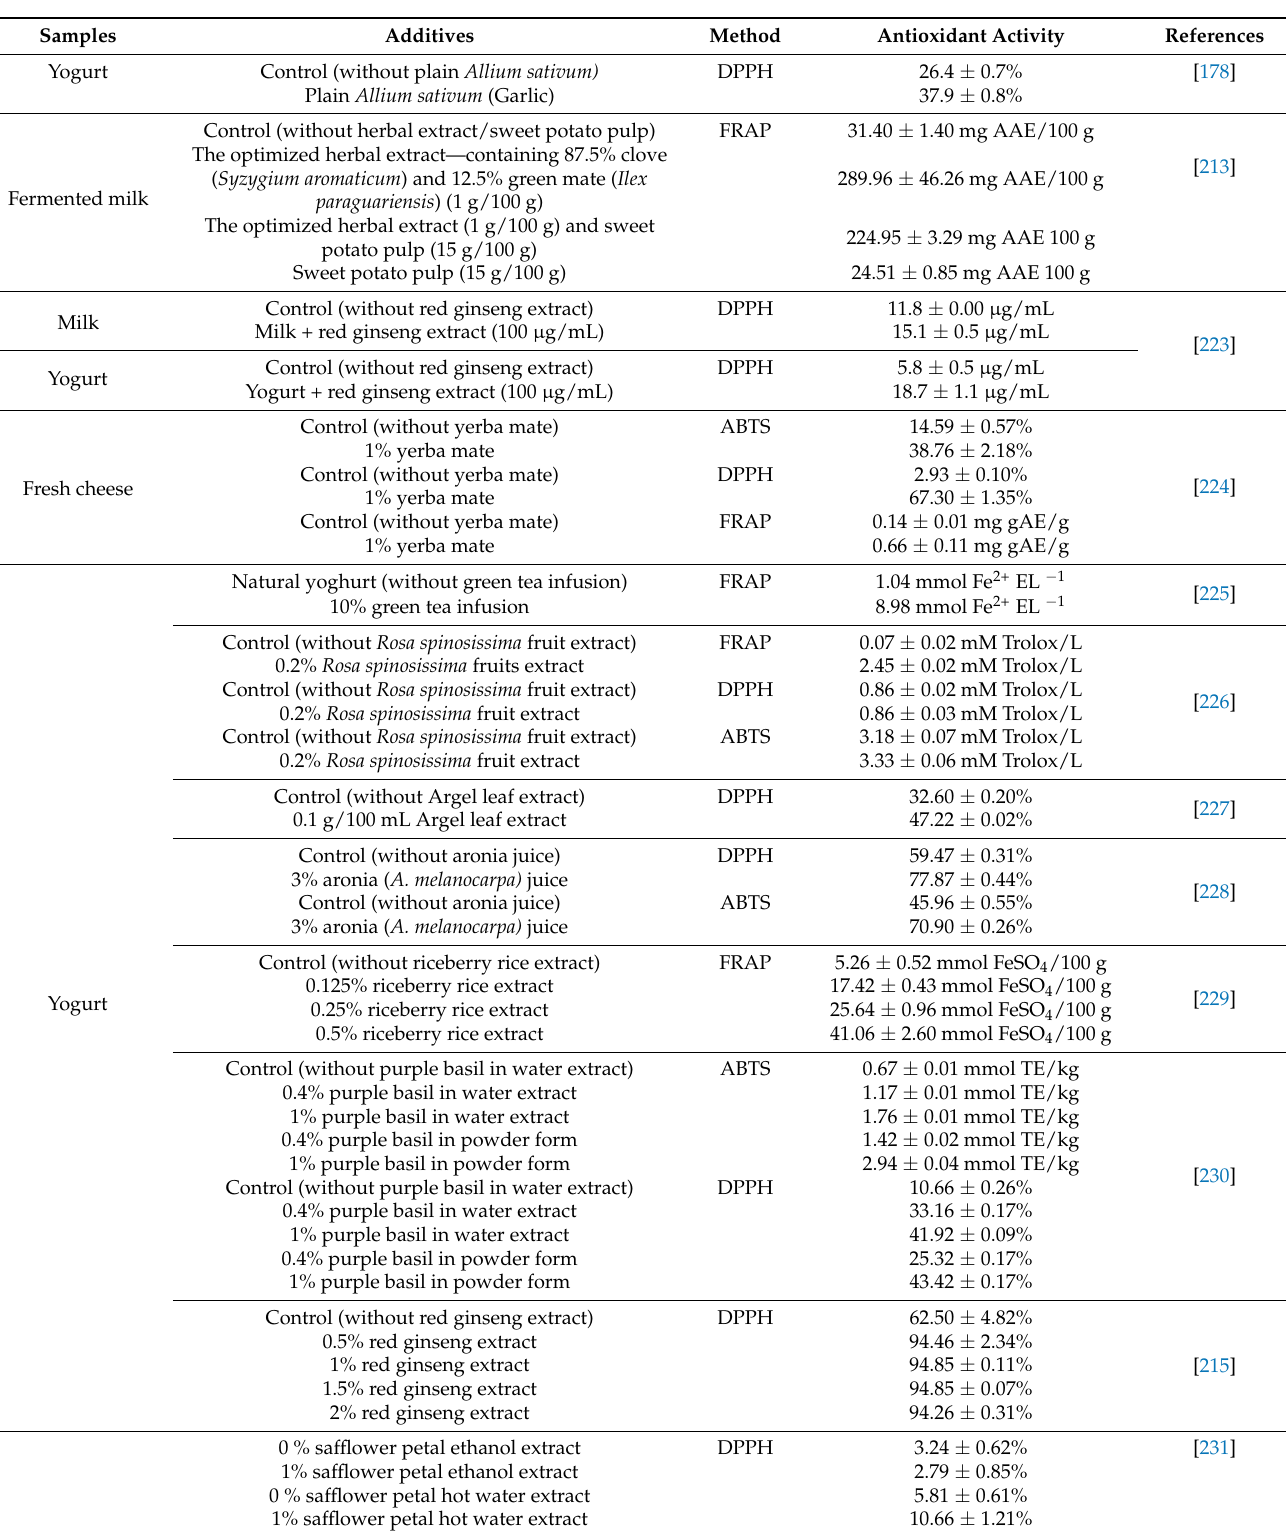
Table 5. Enrichment of milk and dairy products with natural plant additives with high antioxidant potential (own work based on: